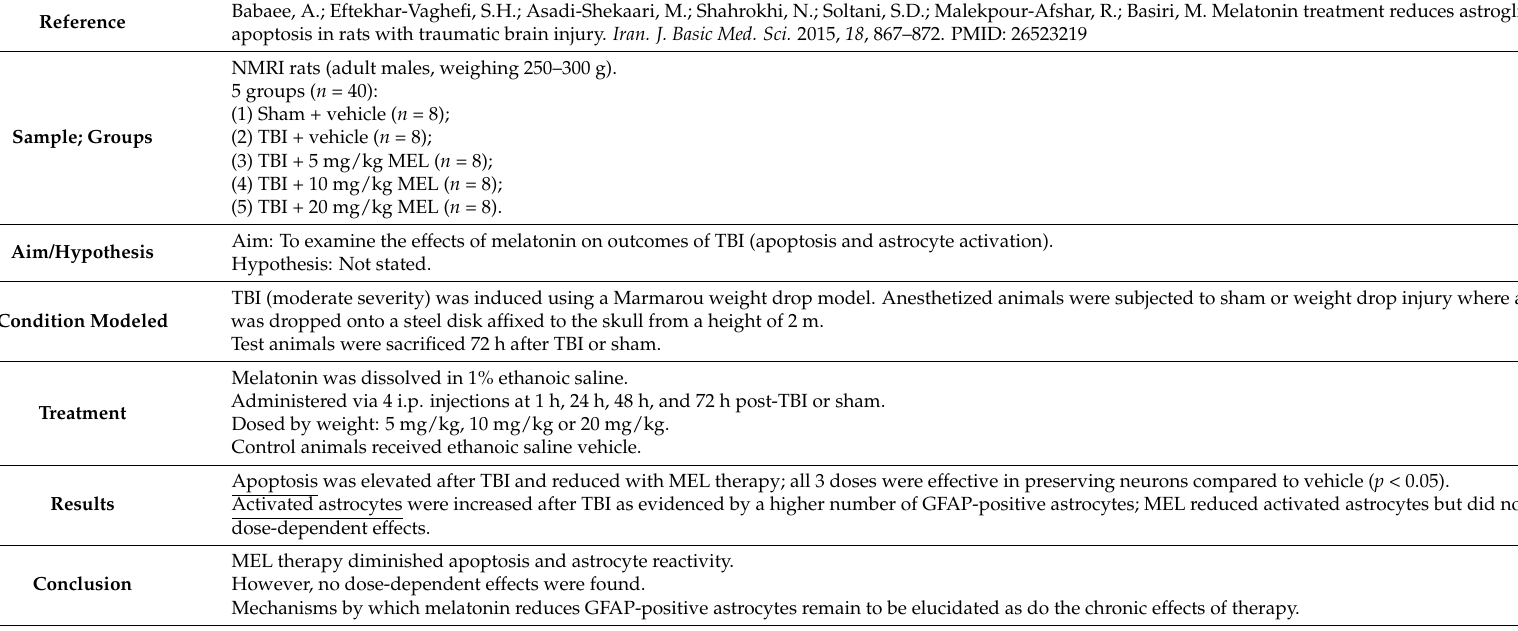
Table A17. Babaee et al. (2015) Study